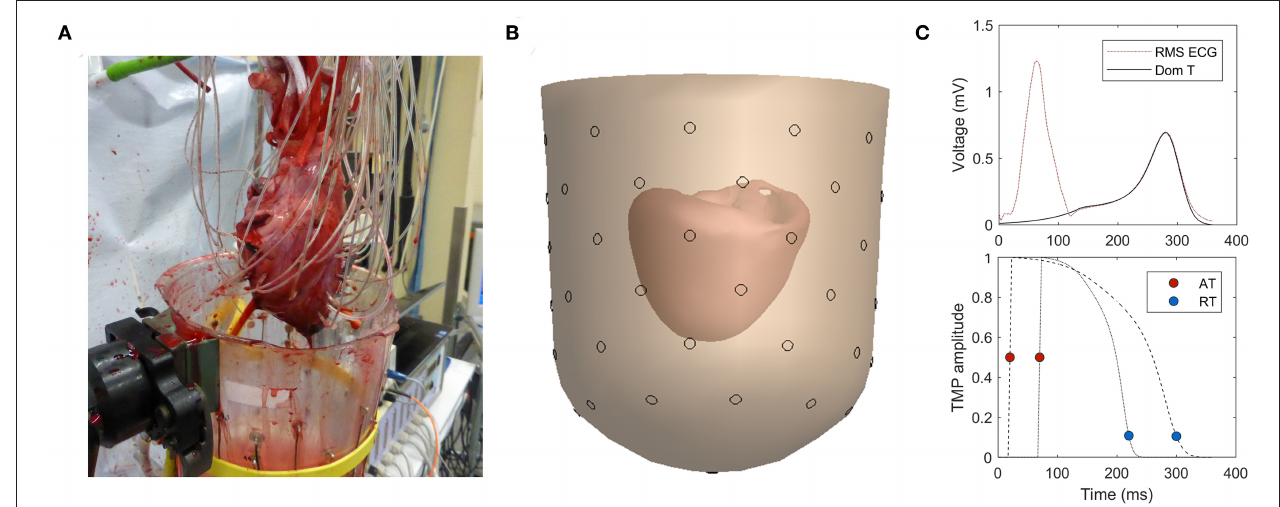
FIGURE 1 | (A) Experimental setup with needles in myocardial wall. (B) 3D reconstruction of heart inside a fluid-filled container. (C) Dominant T-wave determined from T-wave (top) provides the template for the time course of the transmembrane potential (TMP) (bottom; example for two different heart